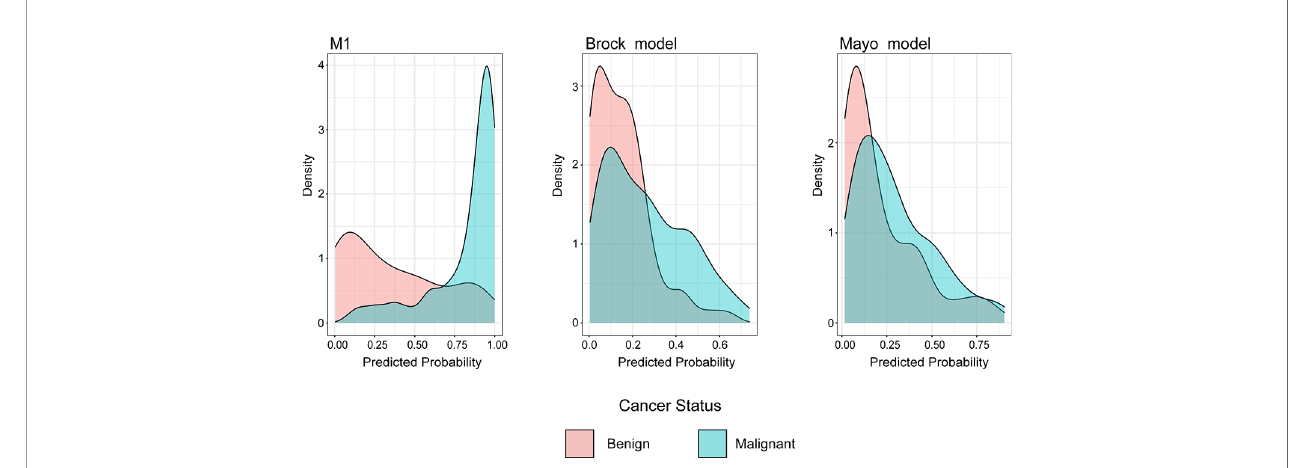
FIGURE 4 | Distributions of predicted lung cancer probability across models for patients with malignant and benign nodules in the validation